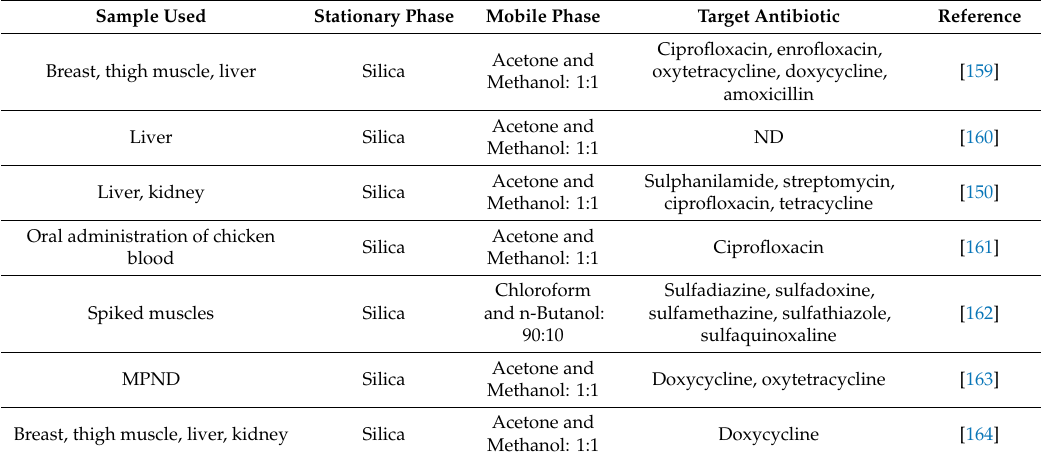
Table 11. TLC-based approaches used for the detection of antibiotic residue in chicken /